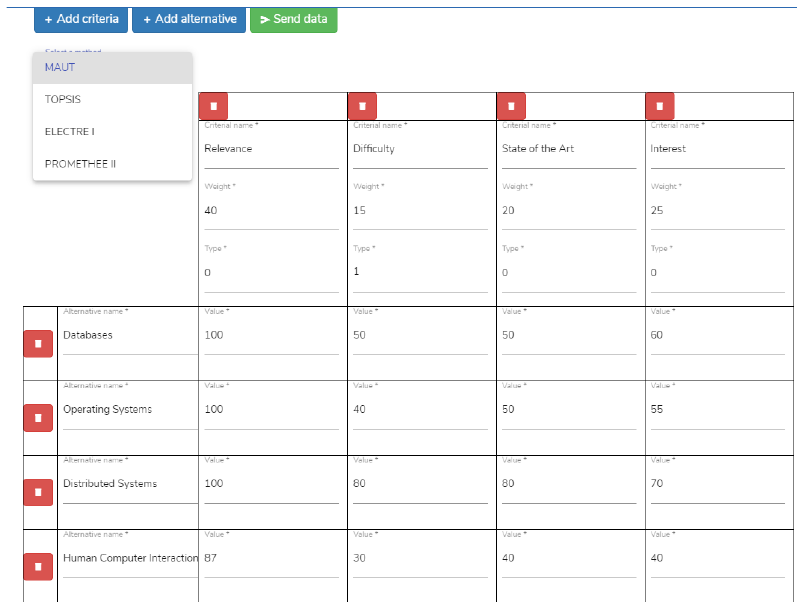
Figure 6. Multi-Criteria Decision Support service input.